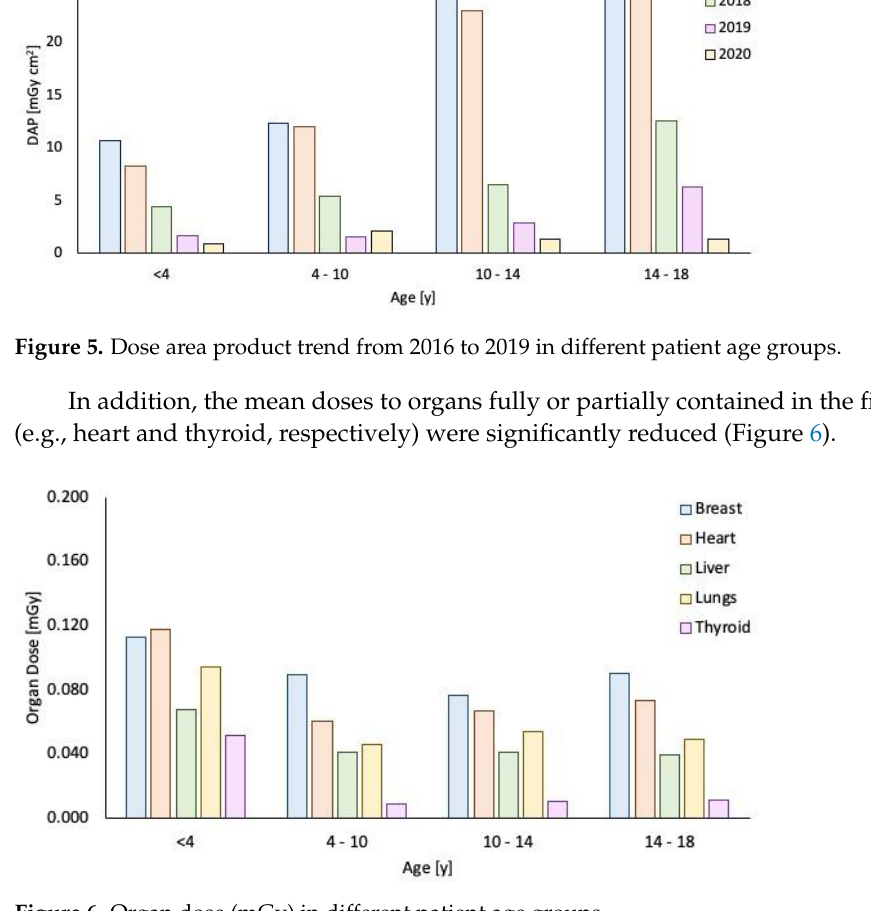
Figure 6. Organ dose (mGy) in different patient age groups.